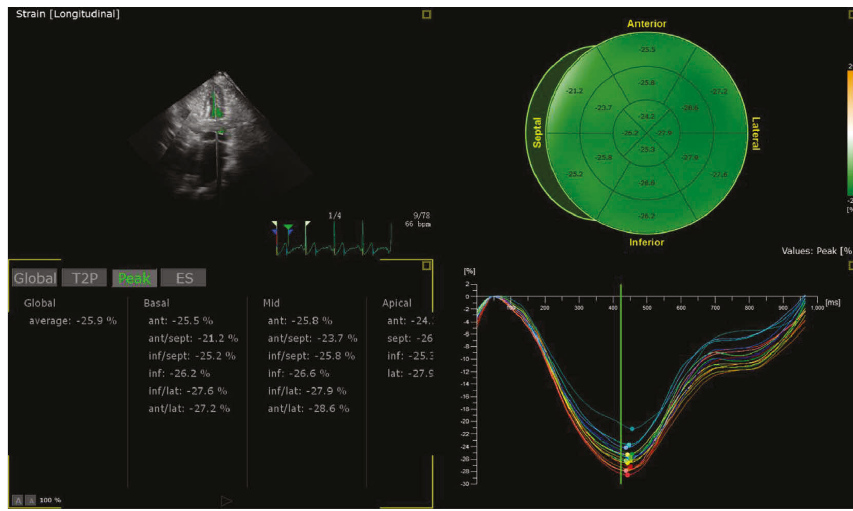
Figure 6: Noncarrier’s illustration of the bull eye. Table 3: Comparison of overall three-dimensional strain indexes between the two groups ( x ± s